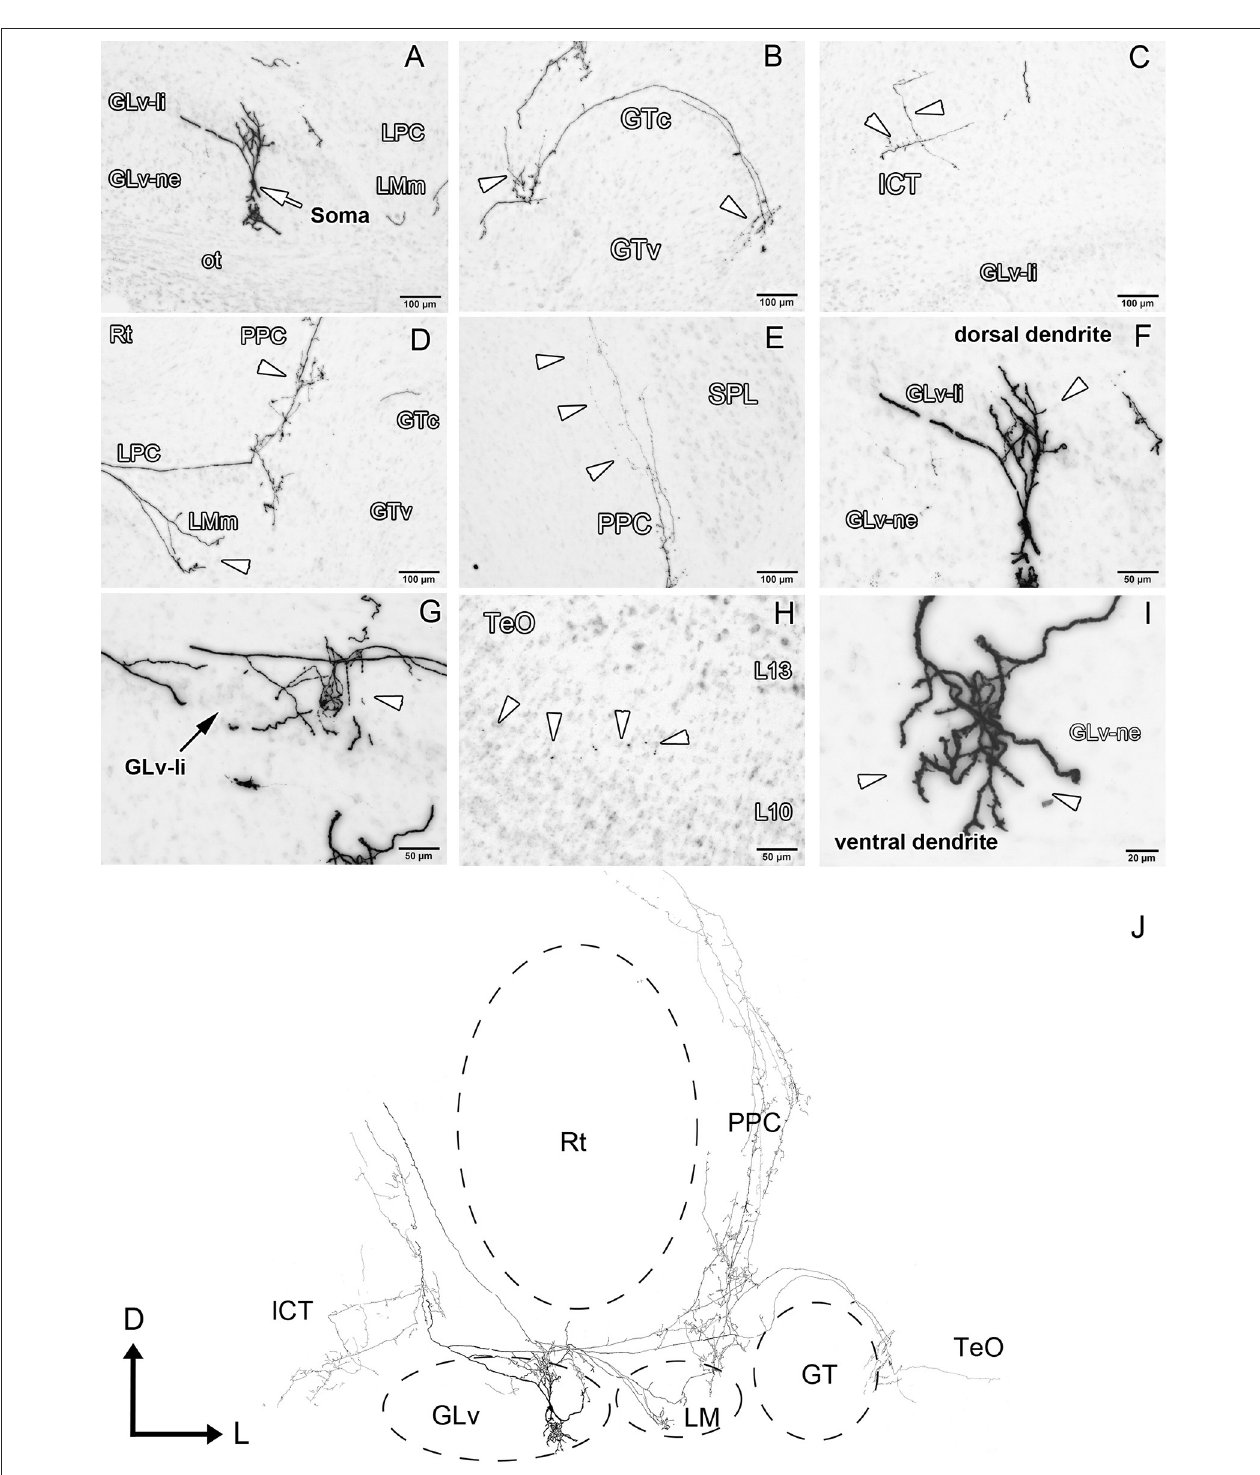
FIGURE 6 | Intracellular filling of a representative GLv-ne type IV cell. (A–I) Photomicrographs showing the soma location and corresponding dendritic processes/axon collaterals throughout different nuclei. White arrowheads indicate the different neuronal processes. (J) Reconstruction of the biocytin-filled neuron. Note the impressive extent a single GLv-ne type IV cell has throughout the thalamus, pretectum and optic tectum. D, dorsal; L, lateral. Orientation in (J) applies to (A–I) .